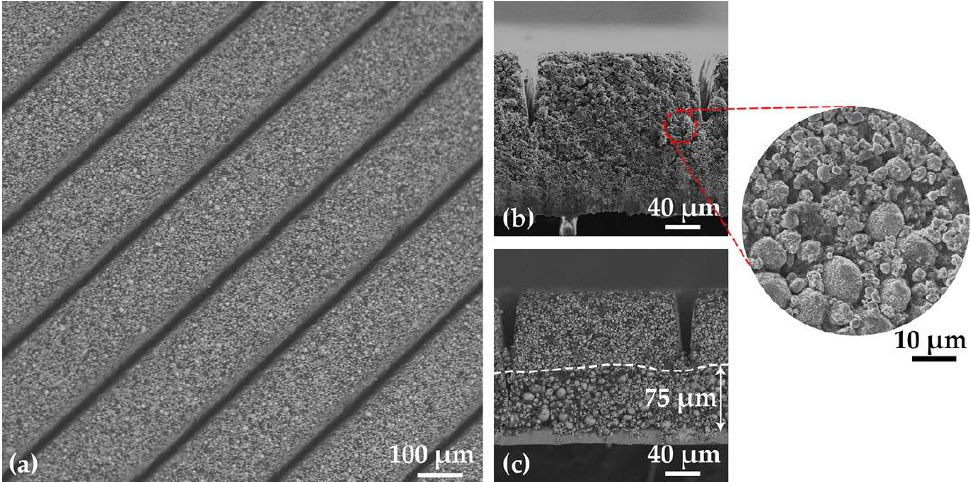
Figure 3. SEM images of ( a ) thick-film electrodes with BT from top view, and the cross section of thick-film electrode with ( b ) BT and ( c ) bilayer BTA 1:1.